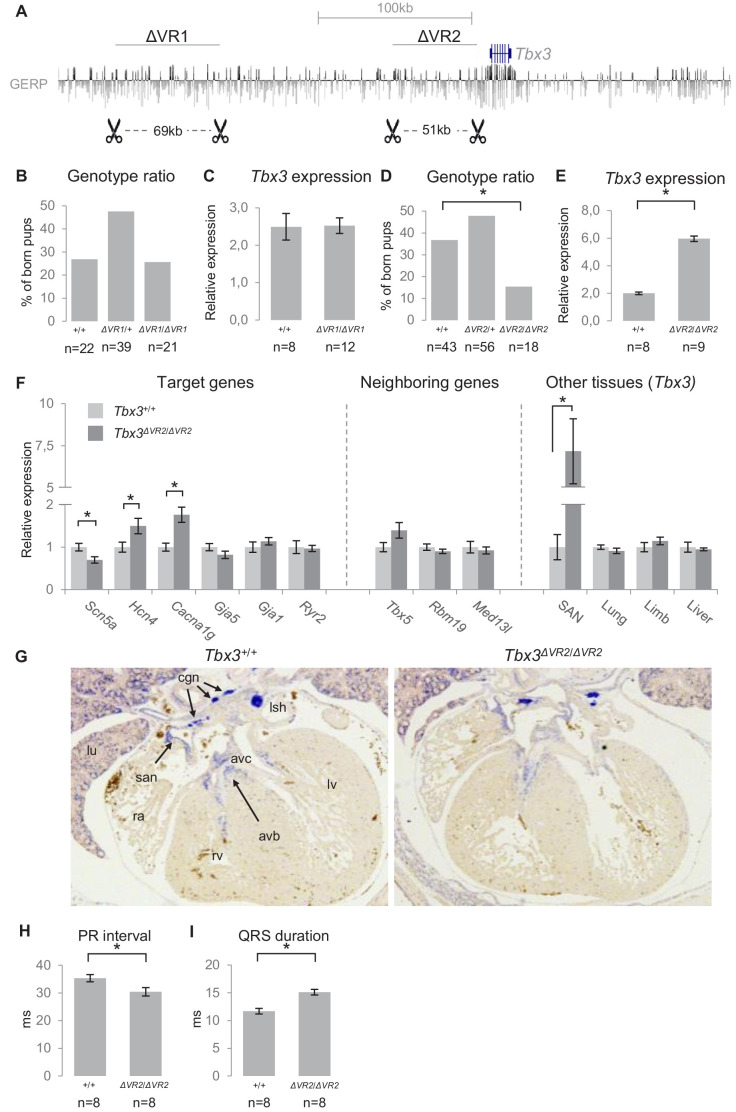
Genomic deletion of VR1 and VR2 in vivo.(A) Mouse genomic regions targeted by TALEN- (VR1) or CRISPR-Cas9- (VR2) mediated genome editing. (B) Genotype ratios of ∆VR1 mutant and wildtype born pups, depicted as percentage of total number of pups. (C) Relative expression levels of Tbx3 in Tbx3+/+ (n = 8) and Tbx3∆VR1/∆VR1 (n = 12) microdissected E13.5 AV junctions. Expression levels are normalized to the expression of Tbx2. (D) Genotype ratios of ∆VR2 mutant and wildtype born pups, depicted as percentage of total number of pups, revealing the number of Tbx3∆VR2/∆VR2 pups is lower than expected according to Mendelian ratios (*: p<0.01). (E) Relative expression levels of Tbx3 in Tbx3+/+ (n = 8) and Tbx3∆VR2/∆VR2 (n = 9) microdissected E13.5 AV junctions, revealing increased expression of Tbx3 in Tbx3∆VR2/∆VR2 mutants (p<0.05). Expression levels are normalized to the expression of Tbx2. (F) Expression levels of target genes of Tbx3 in microdissected E13.5 AV junctions, expression levels of neighboring genes in microdissected E13.5 AV junctions, and expression levels of Tbx3 in other tissues in which Tbx3 is expressed, in Tbx3+/+ (n = 8) and Tbx3∆VR2/∆VR2 (n = 9) E13.5 embryos. Expression levels were normalized to the expression of Tbx2 (AV junctions), Isl1 (SAN) or Hprt (lung, limb, liver). *:p<0.05. (G) In-situ hybridization on sections of Tbx3+/+ and Tbx3∆VR2/∆VR2 E13.5 hearts shows expression of Tbx3 in the cardiac conduction system, including the sinoatrial node, atrioventricular canal, atrioventricular bundle and bundle branches. The expression pattern is not affected in Tbx3∆VR2/∆VR2 hearts. (H,I) PR interval (H) and QRS duration (I) in Tbx3+/+ (WT; n = 8) and Tbx3∆VR2/∆VR2 (hom; n = 8) mice measured by surface ECG on male mice (2–4 months old). *:p<0.05. avb, atrioventricular bundle; avc, atrioventricular canal; cgn, cardiac ganglia; la, left atrium; lsh, left sinus horn; lu, lung; lv, left ventricle; ra, right atrium; rv, right ventricle; san, sinoatrial node.